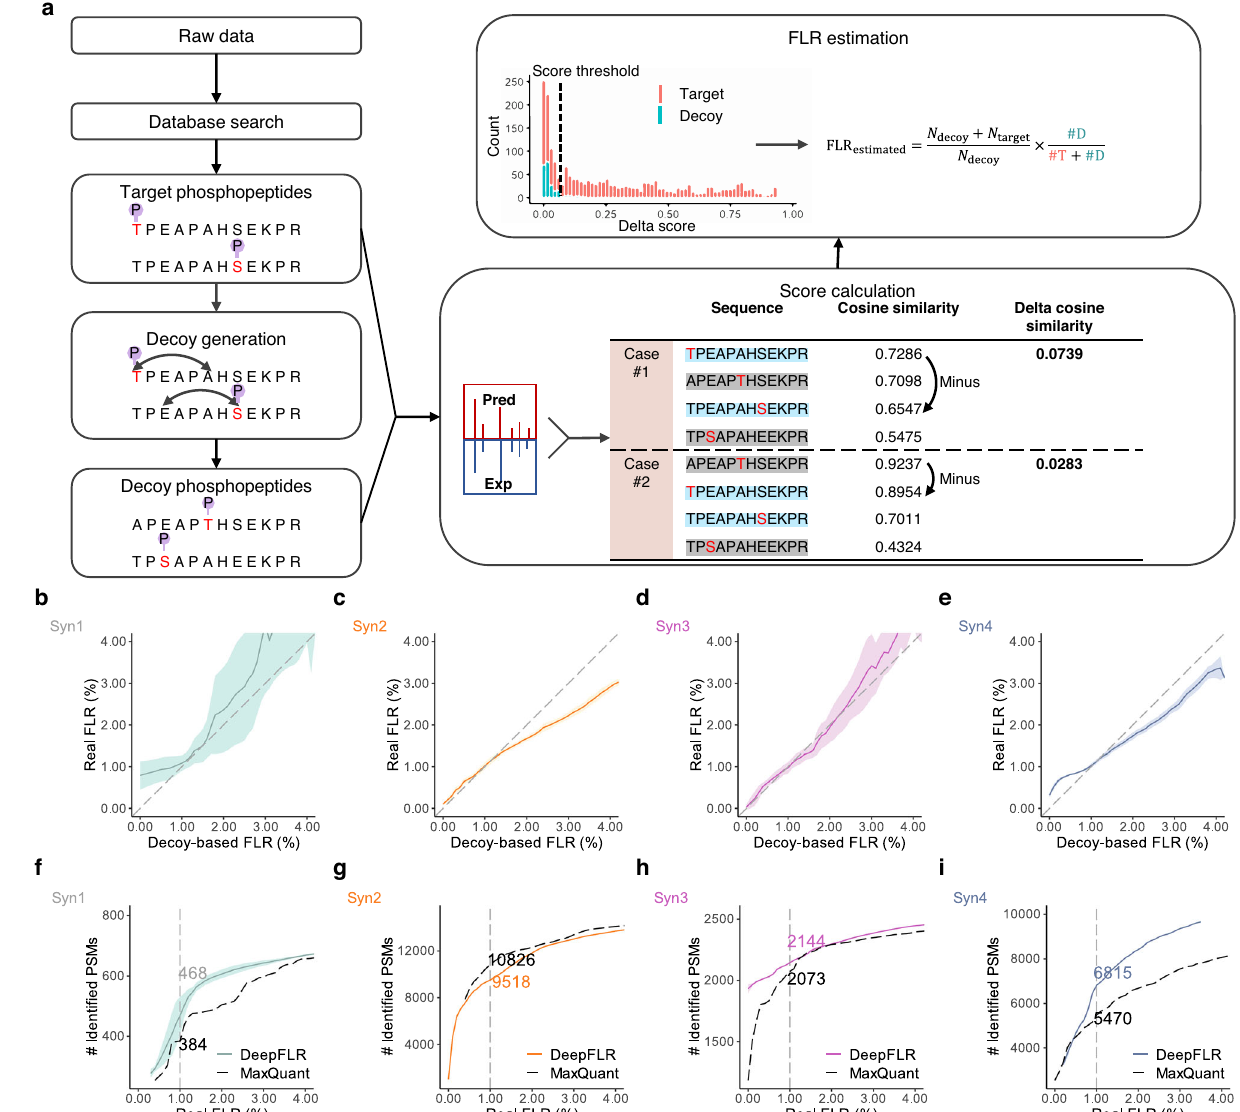
Fig. 2 | FLR control by DeepFLR. a Schematic illustration of the FLR control by DeepFLR. Target phosphopeptides are generated from database searching results byconsideringallpossiblephosphopeptidesisoforms.Decoyphosphopeptidesare generated from the target phosphopeptides by randomly exchanging the phos- phorylated S/T/Y with another amino acid residue in the target sequence. MS/MS spectraarepredictedbyDeepFLRforbothtargetanddecoy.Identi fi cationandFLR estimation are performed based on spectral matching between experimental spectra and the predicted spectra of both the target and decoy. N decoy is the total number of decoy in the database; N t arget is the total number of target in the data- base; # D is the number of identi fi ed decoy hits; and #T is the number of identi fi ed